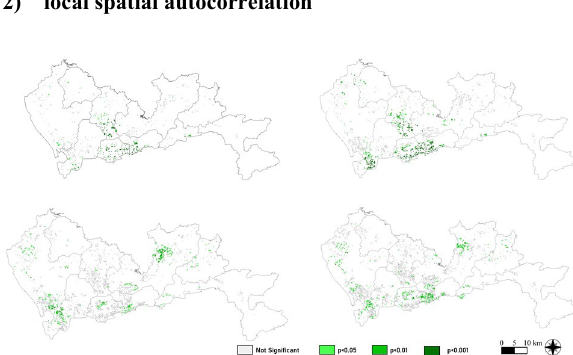
Figure 9. Lisa cluster of mismatch degree of living materials